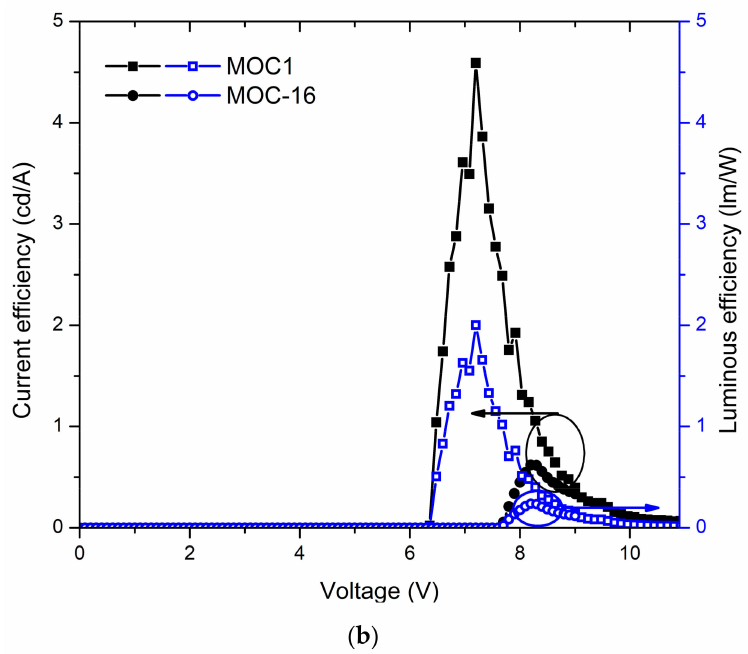
Figure 6. Current and luminous efficiencies of devices based on ( a ) carbazole derivatives (CZ-2 and CZ-1) and ( b ) TPD derivatives (MOC-1 and MOC-16) as emissive